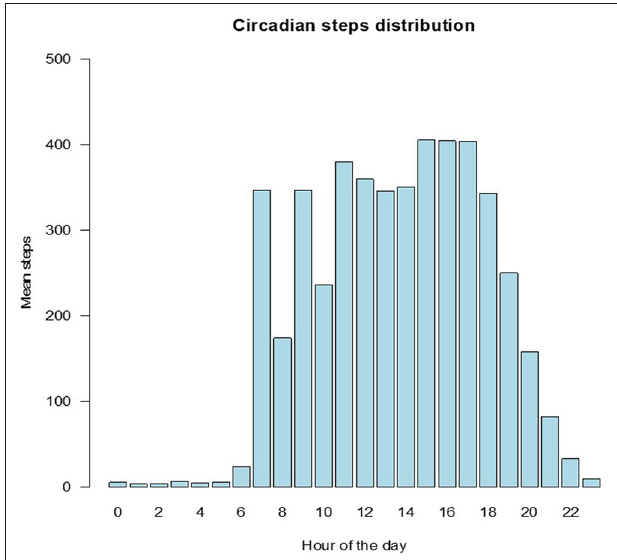
FIGURE 2 | Circadian distribution of